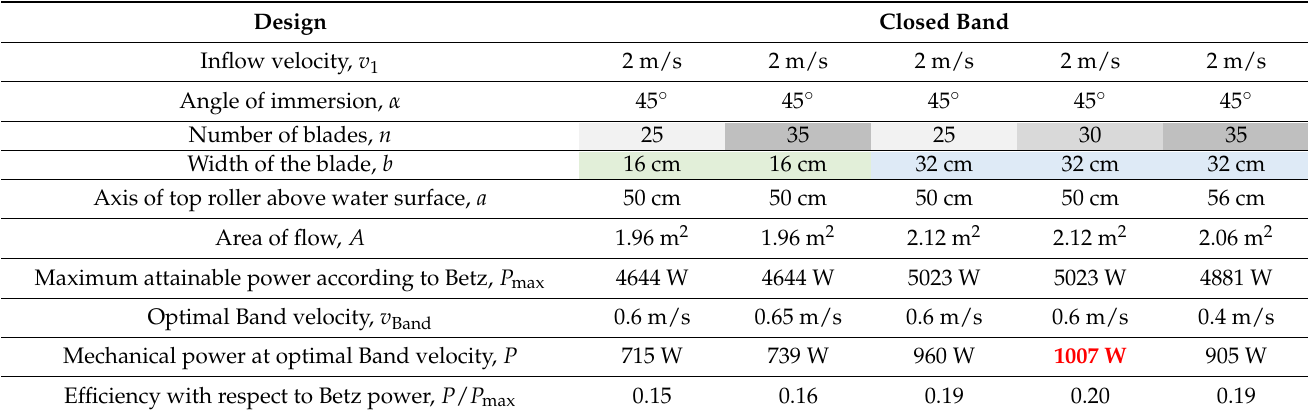
Table 6. Result summary II for Closed-Band ECB (red color is one of the optimum variants which is mentioned later in the